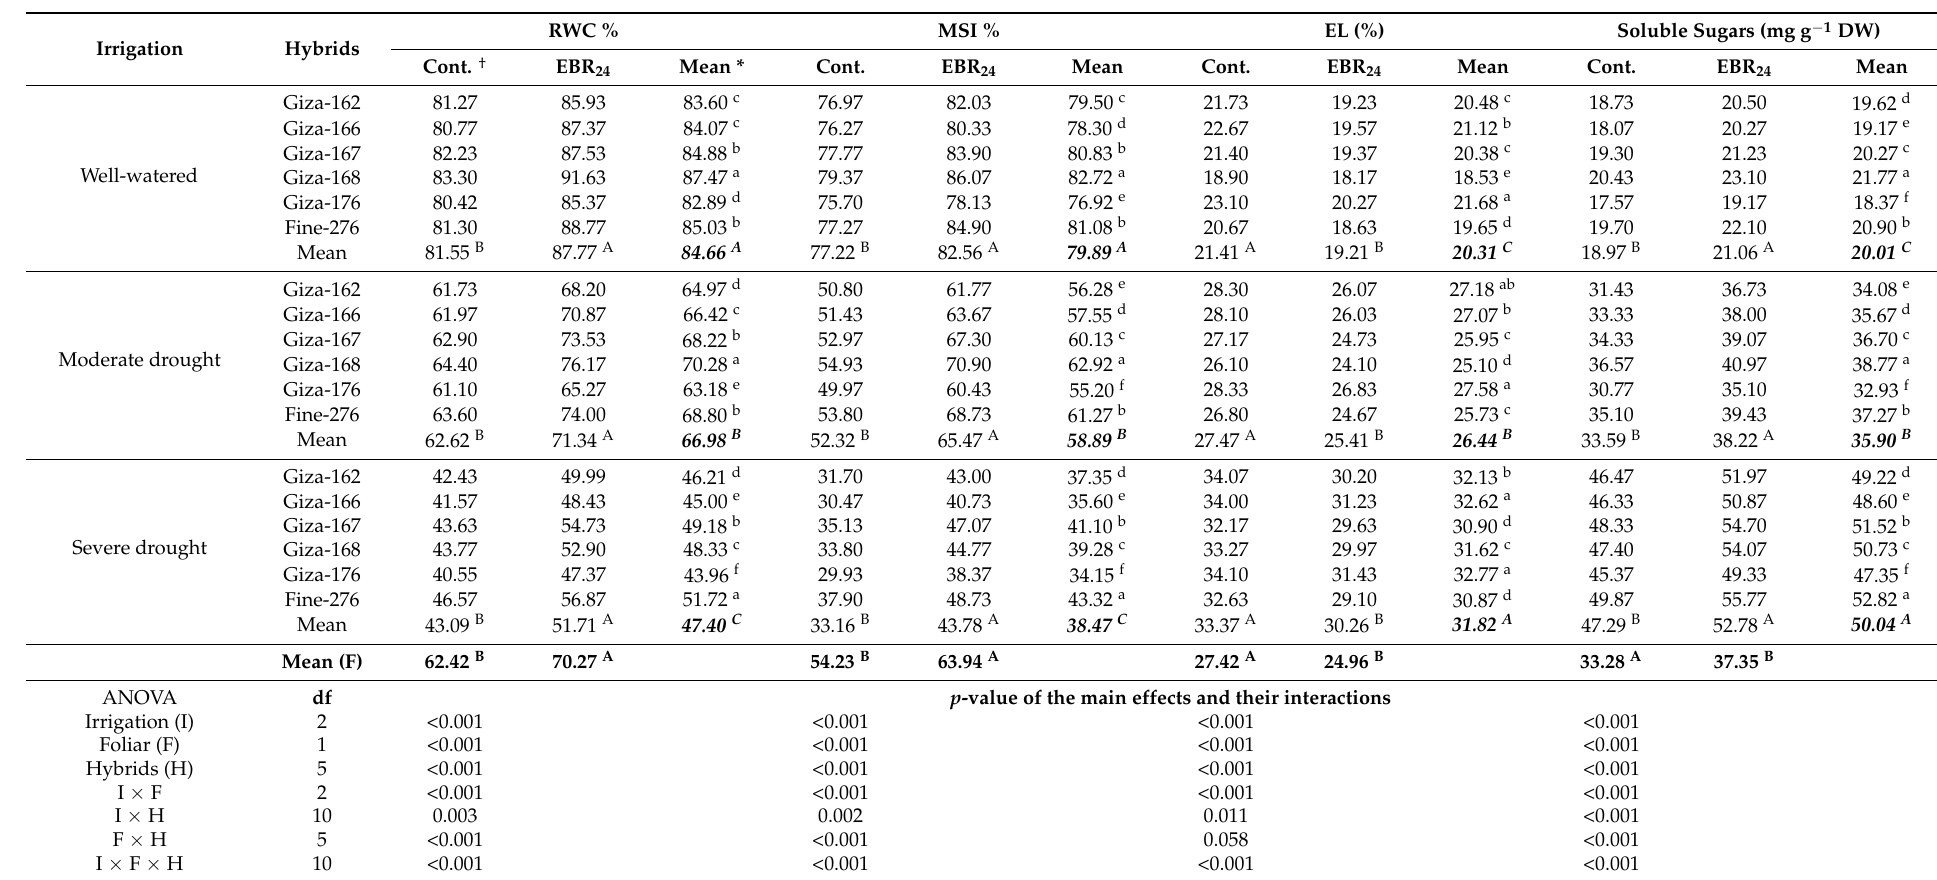
Table 4. Impact of the 24-epibrassinolide (EBR 24 ) application on the relative water content (RWC), membrane stability index (MSI), electrolyte leakage (EL), and soluble sugars content of six maize hybrids grown under three irrigation regimes over the two growing seasons of 2018 and 2019. Irrigation